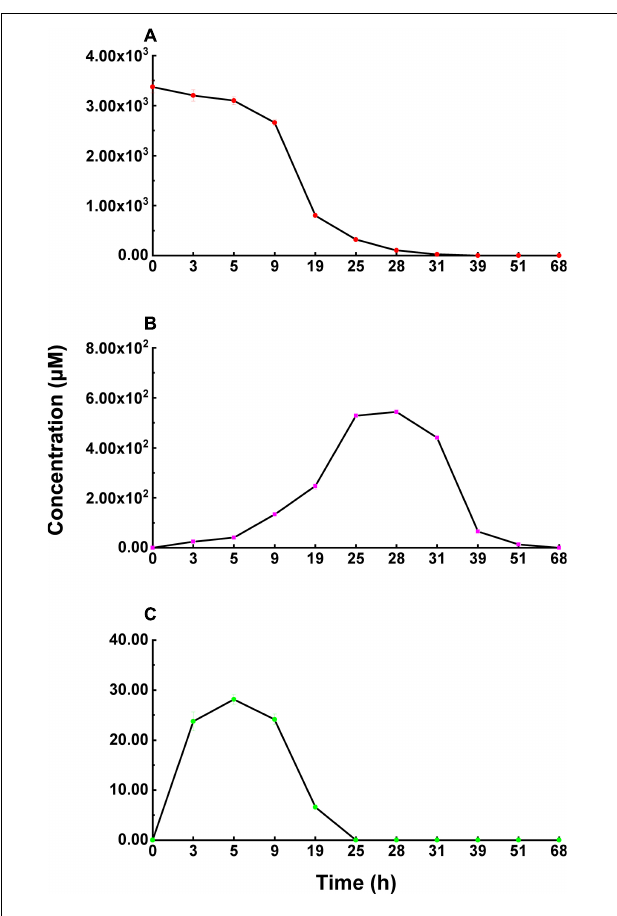
FIGURE 5 | The concentration changes of 3- epi -DON (B) and 3- keto -DON (C) in the process of DON (A) degradation by Nocardioides sp. ZHH-013.